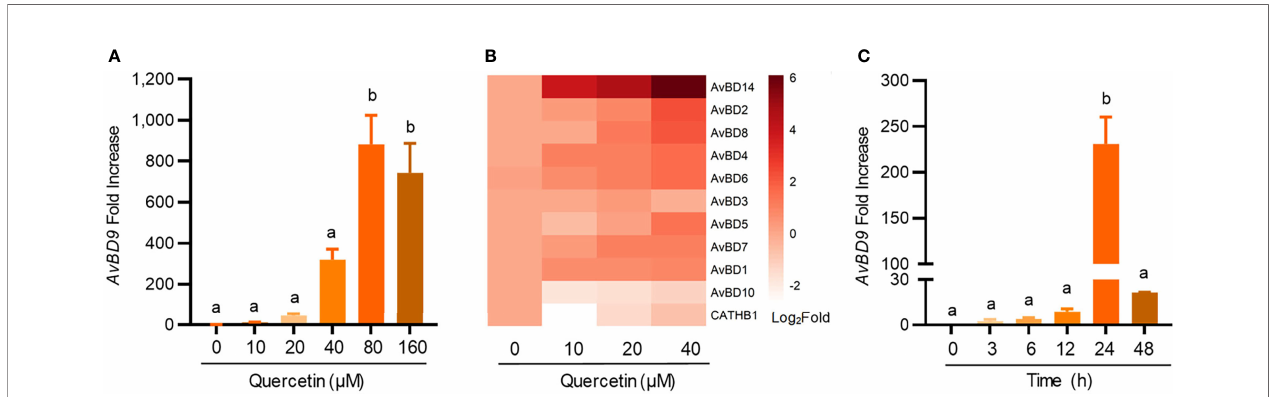
FIGURE 1 | Dose- and time-dependent induction of chicken host defense peptide (HDP) gene expressions by quercetin. Chicken HTC macrophage cells were treated in duplicate with indicated concentrations of quercetin for 24 h, followed by RT-qPCR analysis of avian b -defensin 9 ( AvBD9 ) (A) and other HDP genes (B) . (C) HTC cells were also treated with 40 µM quercetin for indicated times, followed by AvBD9 expression analysis. Results are expressed as means ± SEM of three independent experiments. The bars not sharing common superscript letters are signi fi cantly different ( P < 0.05) as determined by one-way ANOVA and post hoc Tukey ’ s